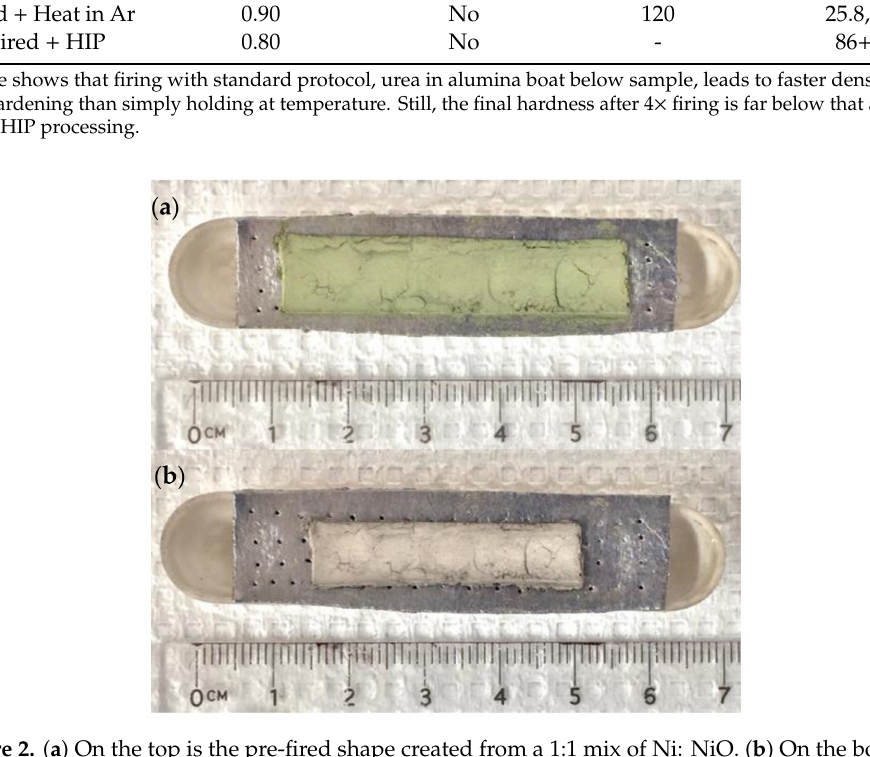
Figure 2. ( a ) On the top is the pre-fired shape created from a 1:1 mix of Ni: NiO. ( b ) On the bottom is the shape after firing. There is clearly shrinkage and reduction of